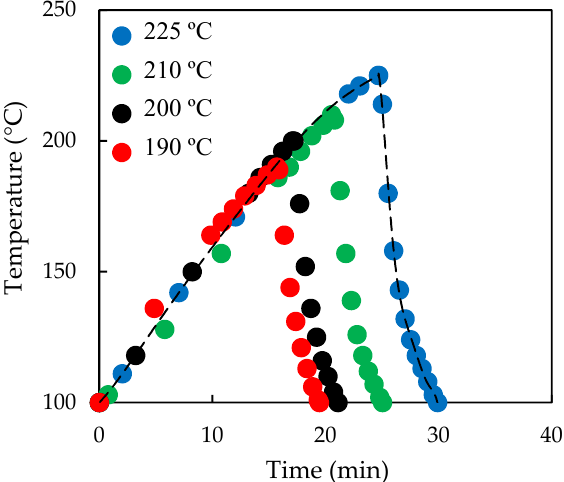
Figure 1. Temperature profiles for LHW pre-treatments performed at four different maximum temperatures and 0 min maintenance time at these temperatures.